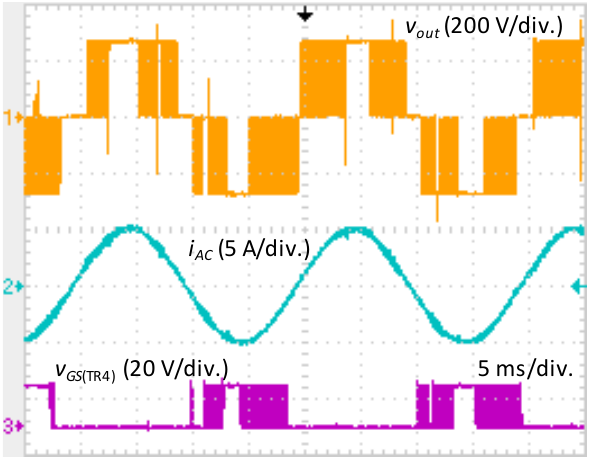
Figure 14. Waveforms from T-type bridge-leg configured in the common-drain connection in Figure 1 when it is being driven by the gate driver circuitry in Figures 8 and 11.